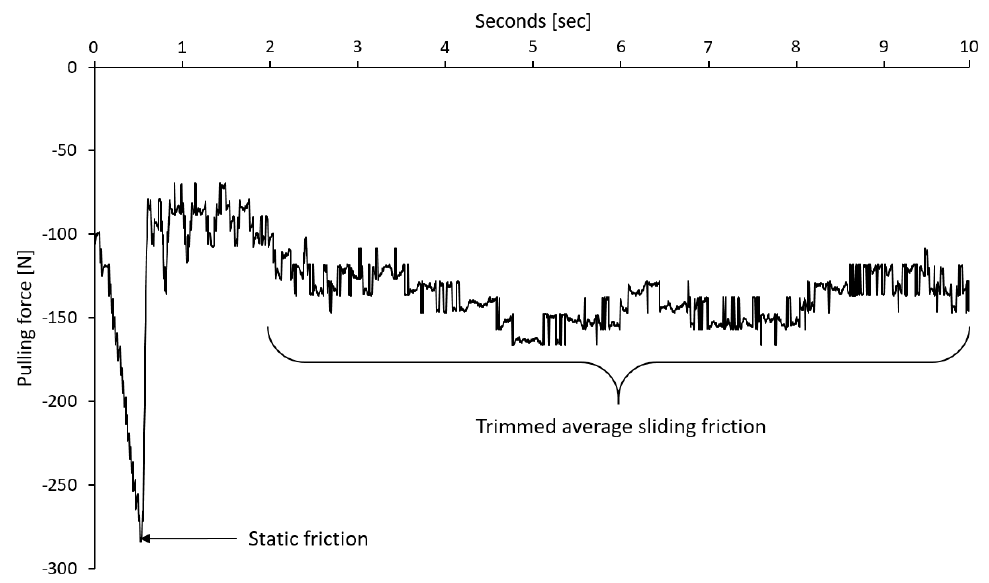
Figure 4. Example of a typical pulling force measurement curve in function of time.